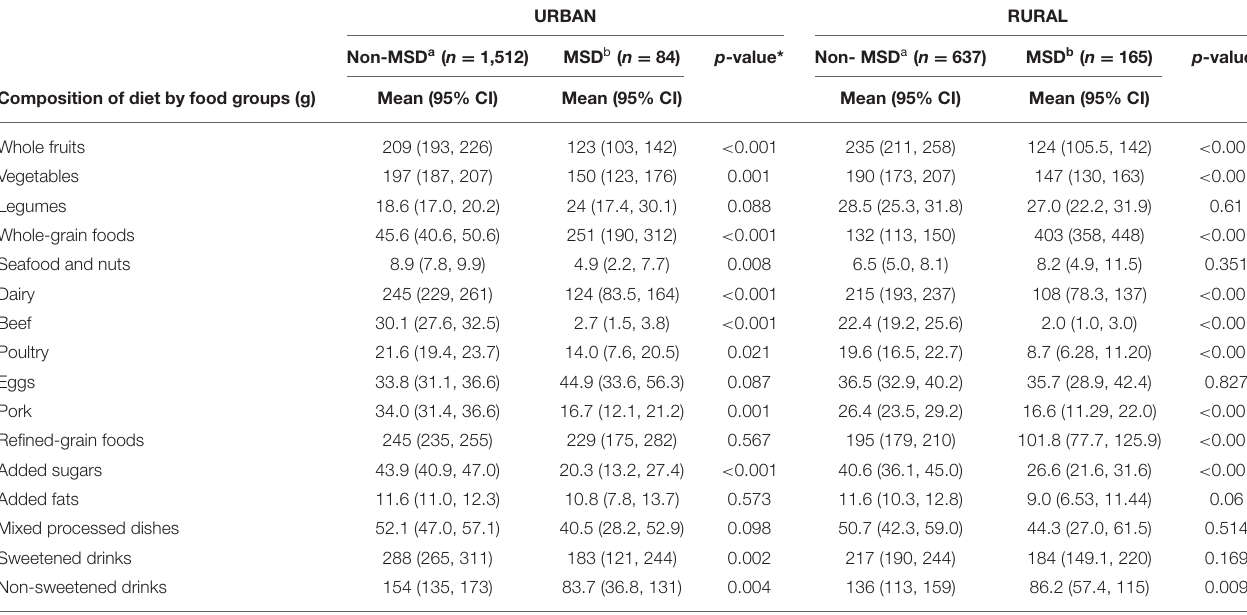
TABLE 2 | Comparison of intake of food groups among adults with and without more sustainable diets (MSD) in urban and rural areas of Mexico. URBAN RURAL